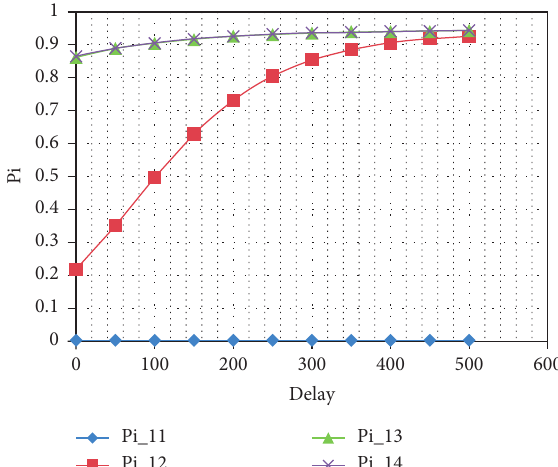
Figure 13: P I versus ADT, for 4 scenarios, showing increasing contribution values of